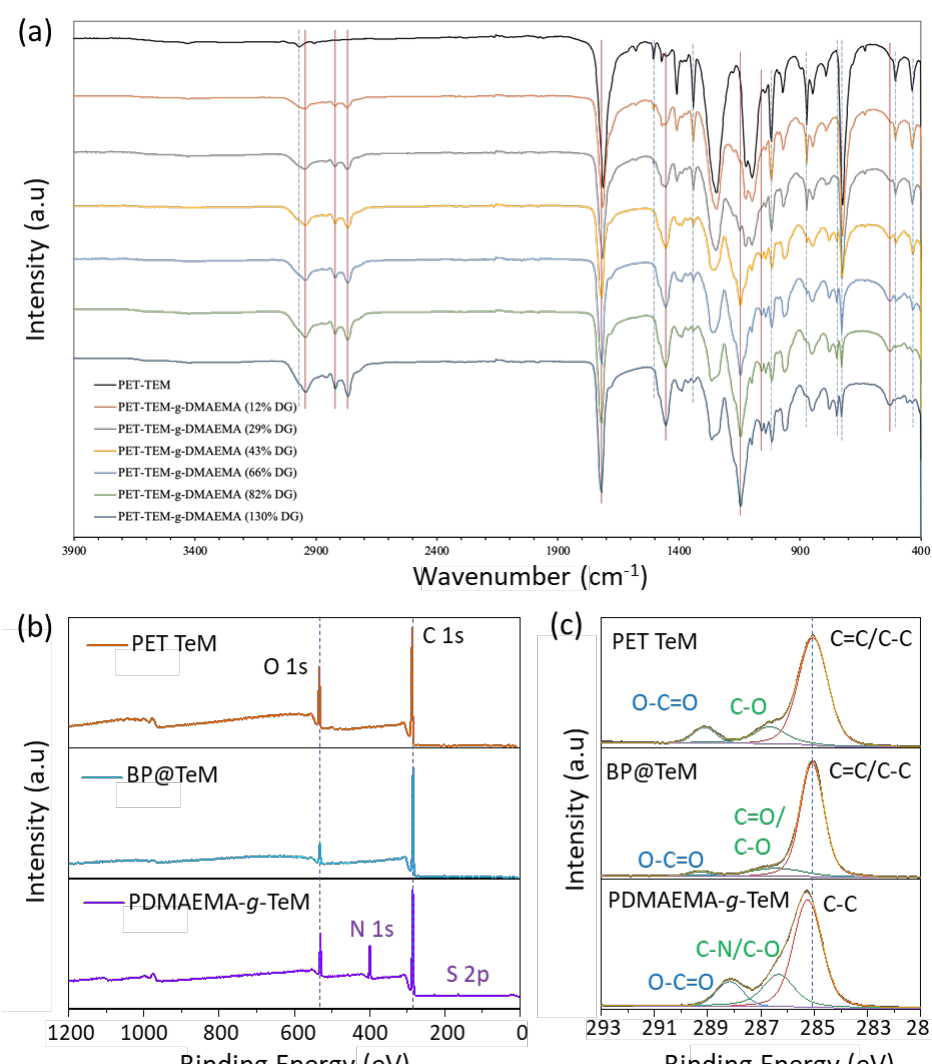
Figure 3. FTIR spectra of pristine PET TeM and PDMAEMA grafted membranes with different degrees of grafting ( a ). XPS survey wide scan spectra ( b ) and core-level C 1s spectra of PET TeM, BP immobilized PET TeM (BP@TeM), and PDMAEMA- g -TeM (DG: 12%) ( c ).